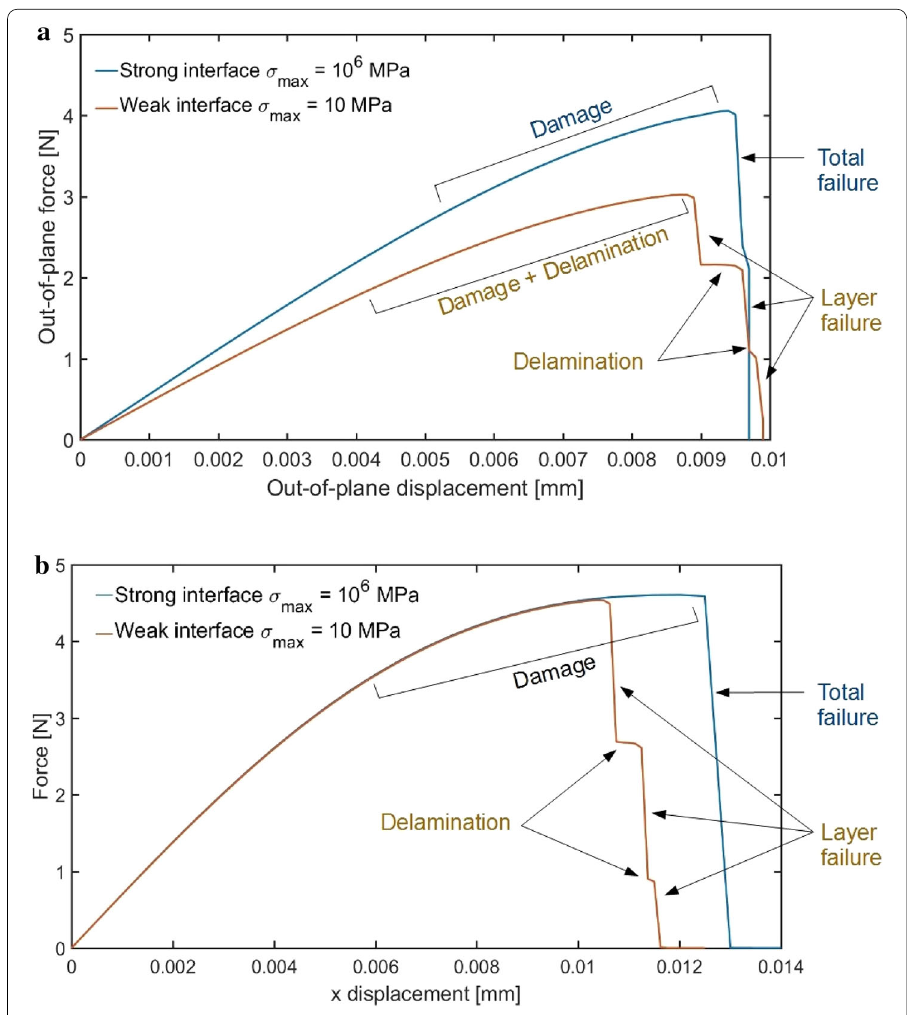
Fig. 16 Force-displacement curves. a Sandwich panel under tension and 4-point-bending, b Sandwich cylinder under tension (from [47])